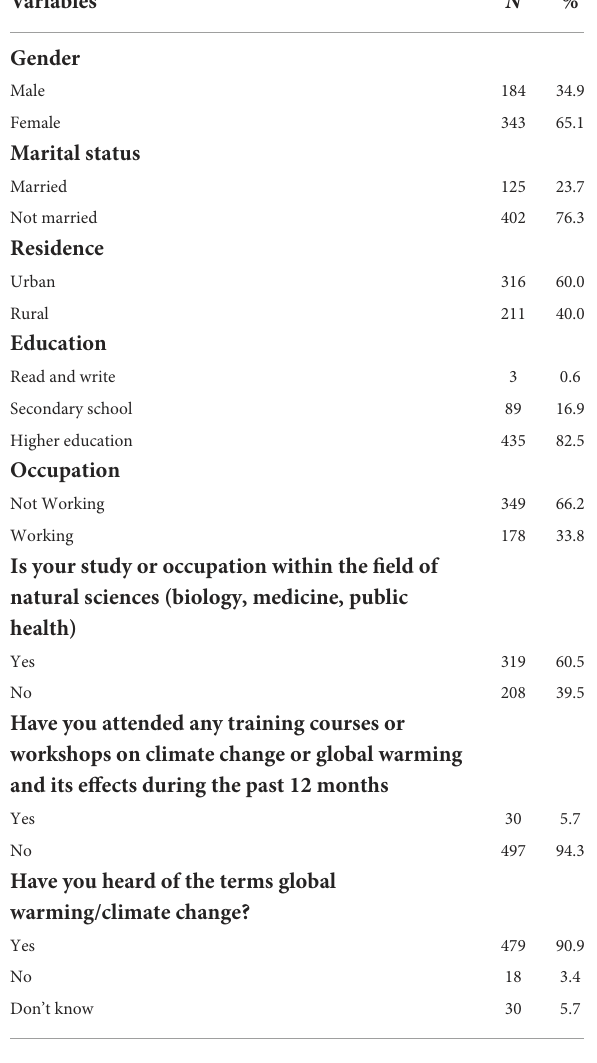
TABLE 1 Baseline characteristics of the study participants ( N =